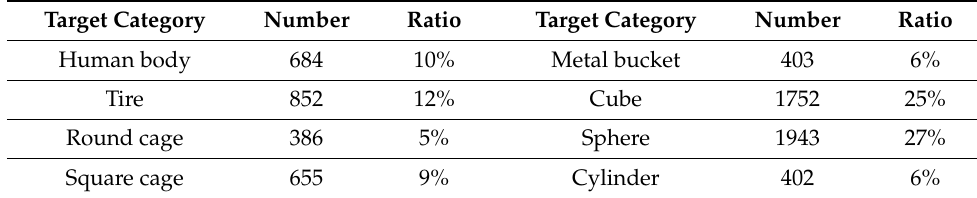
Table 3. The number and ratio of each category of STSD.